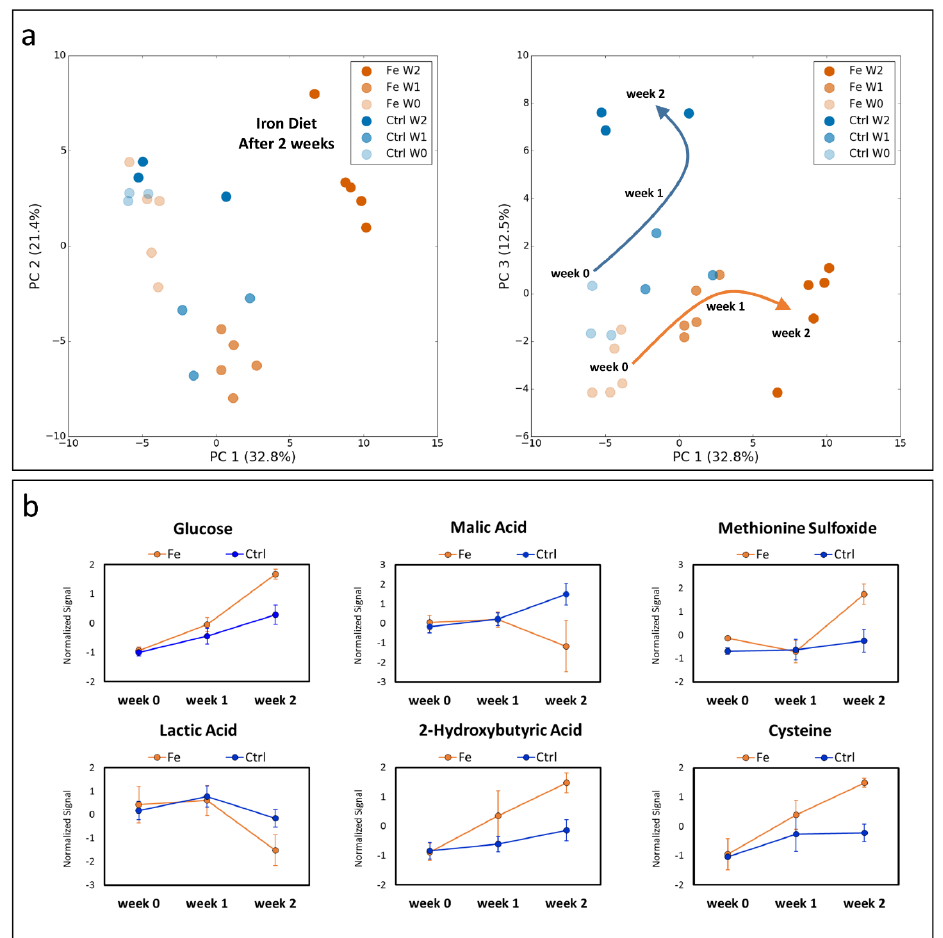
Figure 1. Metabolic profiles of iron diet fed mice over a period of two weeks. Principal component analysis (PCA) ( a ) of peripheral blood metabolites shows metabolic profile changes overtime and distinct metabolic signatures between dietary iron challenged and control animals. Specific profiles of selected metabolites ( b ) shows their quantitative changes over time. Controls (Ctrl, blue, n = 3), high-iron diet (Fe, orange, n = 5). Statistics: 2-way ANOVA was performed, a p -value < 0.05 was considered to be significant.